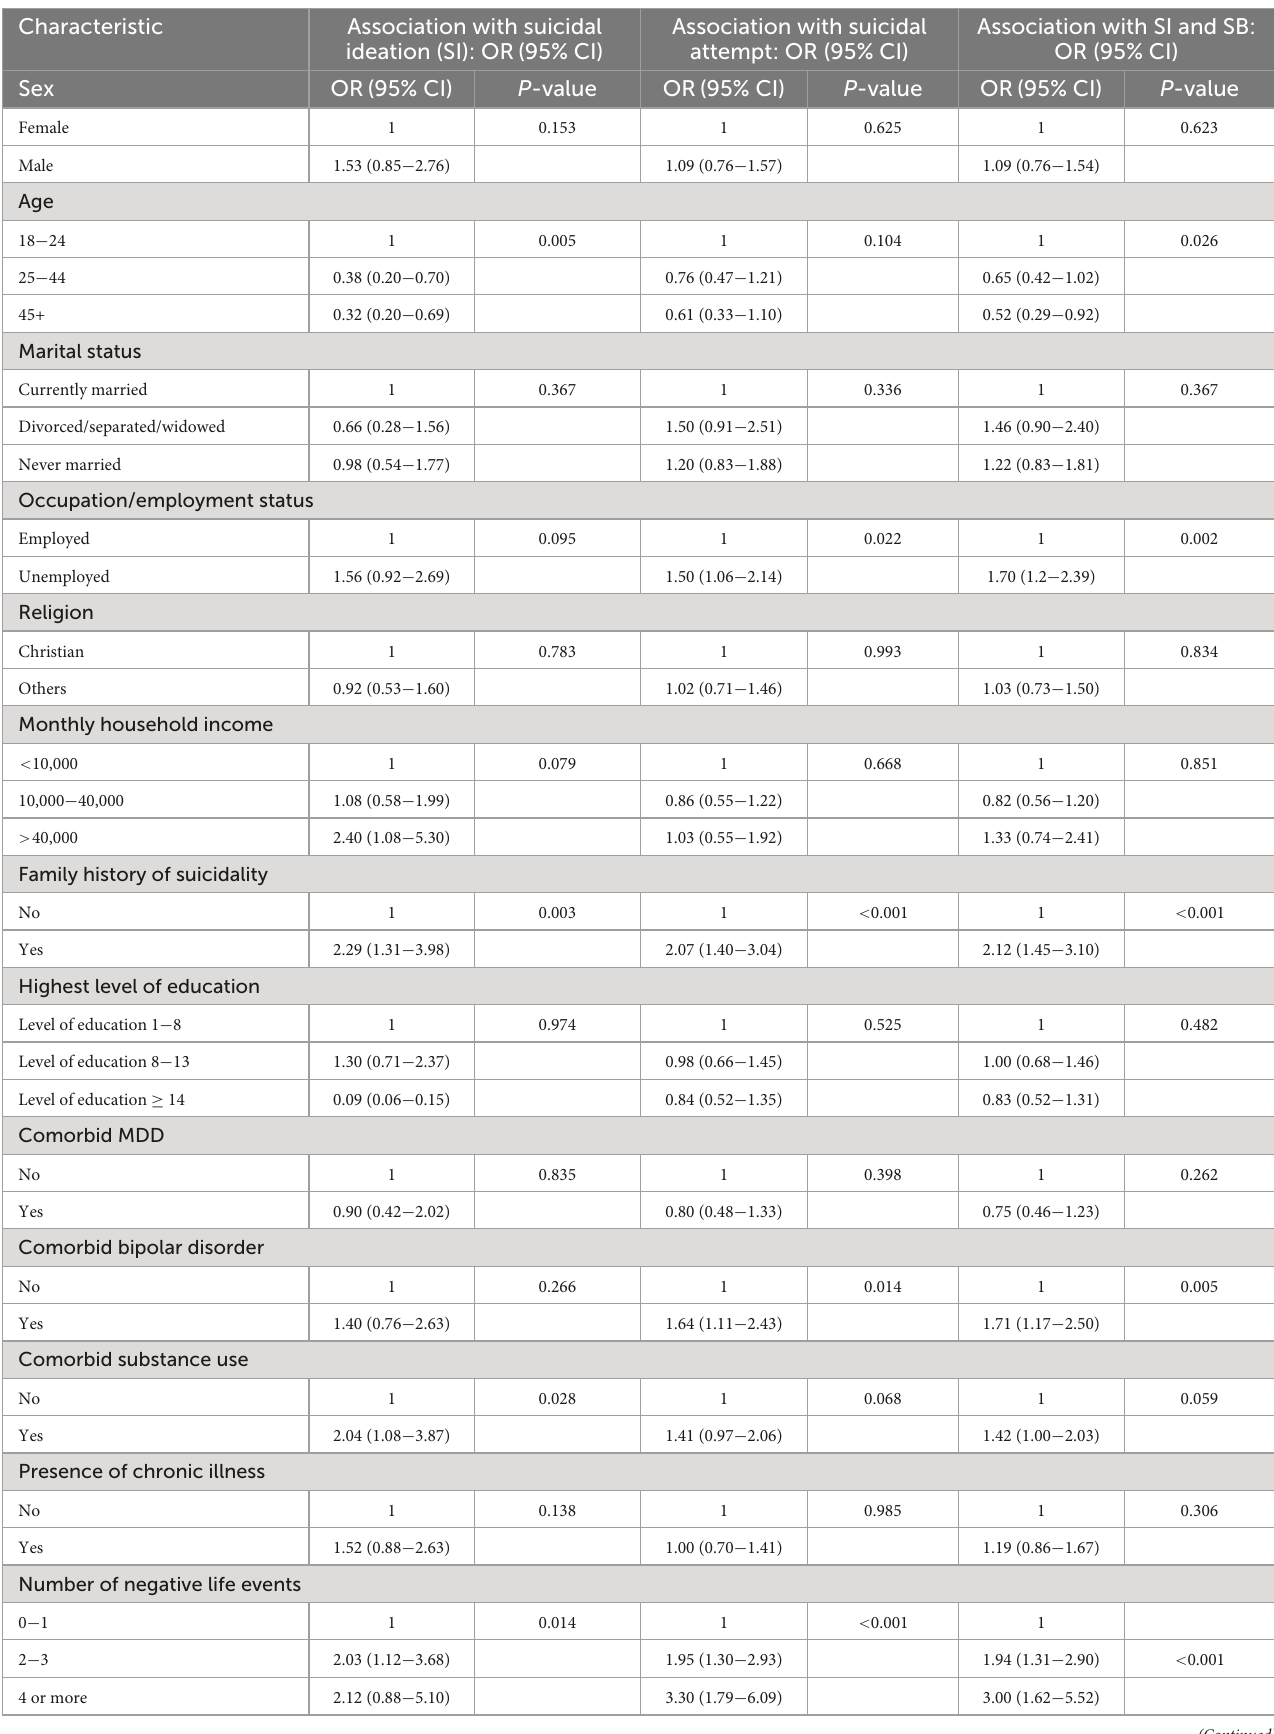
TABLE 2 Univariate risk factors for suicidal ideation, suicidal attempts, and suicidal behavior (from univariate analyses), N = 619. Characteristic Association with suicidal Association with suicidal Association with SI and SB: ideation (SI): OR (95% CI) attempt: OR (95% CI) OR (95%